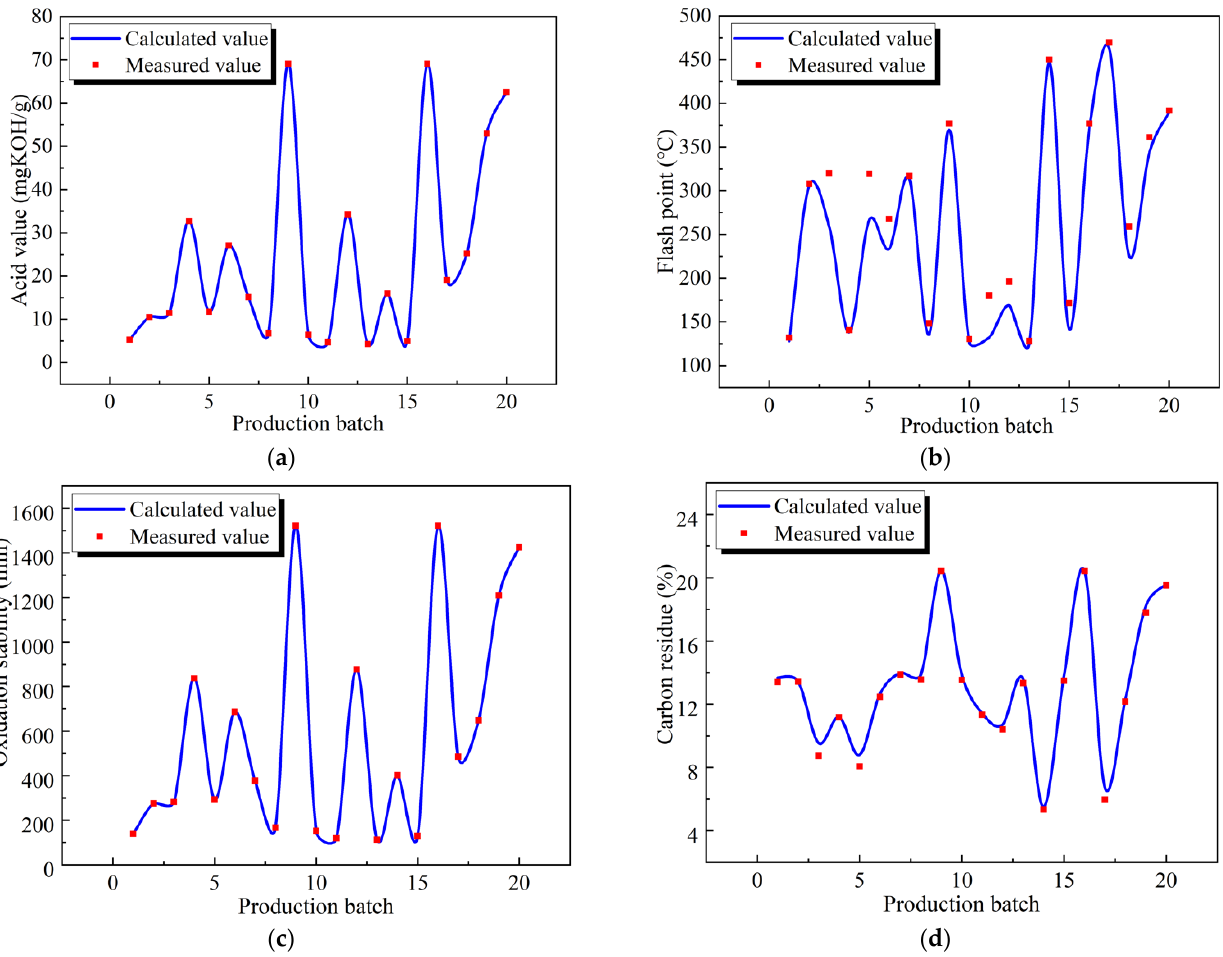
Figure 4. Comparisons between calculated and measured values. ( a ) Acid value; ( b ) flash point; ( c ) oxidation stability; ( d ) carbon residue.